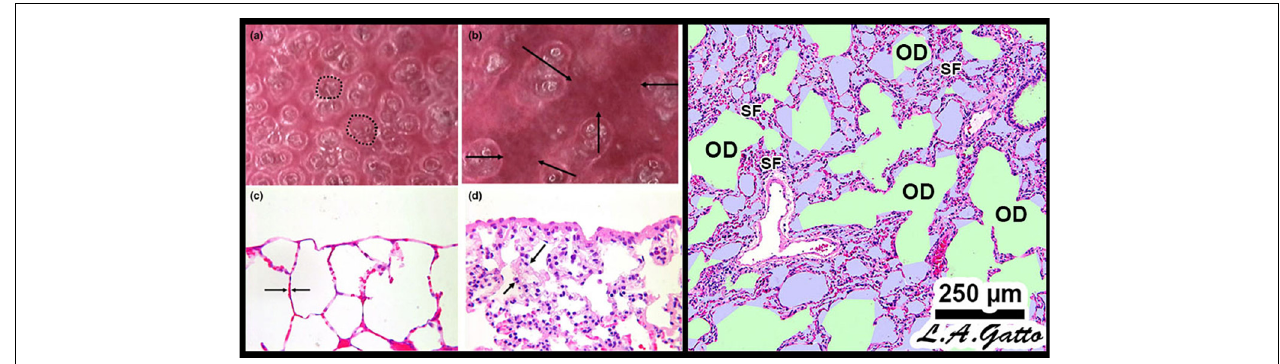
FIGURE 4 | Mechanical mechanisms of ventilator-induced lung injury (VILI) in the microenvironment: Left – In vivo subpleural alveoli in an acutely injured rat lung at inspiration (a) and expiration (b) . Lung histology in the same rat lung injury model fixed at inspiration (c) and expiration (d) (Pavone et al., 2007). Alveolar recruitment/derecruitment (R/D) causing atelectrauma can be seen as fully recruited alveoli filling the microscopic field (white circles, two of which are highlighted with black dotted line) (a) that collapse during expiration (red atelectatic areas highlighted by arrows) (b) . Histology shows open alveoli at inspiration with a shared alveolar wall highlighted by arrows (c) that collapse with expiration by alveolar wall folding, identified by arrows. Right – Stress-focus (SF) in areas with collapsed alveoli. SF adjacent to open alveolar ducts, causing alveolar duct overdistension (OD) . SF-induced OD causes excessive mechanical stress and strain on alveolar duct walls, resulting in damage to pulmonary parenchymal cells (Ghadiali and Gaver, 2008). Loss of surfactant function results in alveolar instability ( Figure 3 , R/D). Histology at exhalation in a rat Tween-induced surfactant deactivation model with a tidal volume of 6 ml/kg and a PEEP of 5 cm H 2 O. Note the heterogeneous collapse of alveoli causing areas of stress-focus (SF). Adjacent to these areas of SF are overdistended (OD) alveolar ducts (Kollisch-Singule et al., 2014b). Summary – R/D causes excessive normal or “peeling” stress as the adhered alveolar walls peel apart during inflation; both R/D and SF cause OD in adjacent open stable tissue. This excessive stress and strain on alveolar walls results in lung parenchymal cell death and is a major VILI mechanism. Permissions obtained to reuse panels (a–d) (Pavone et al., 2007). Springer Nature license number